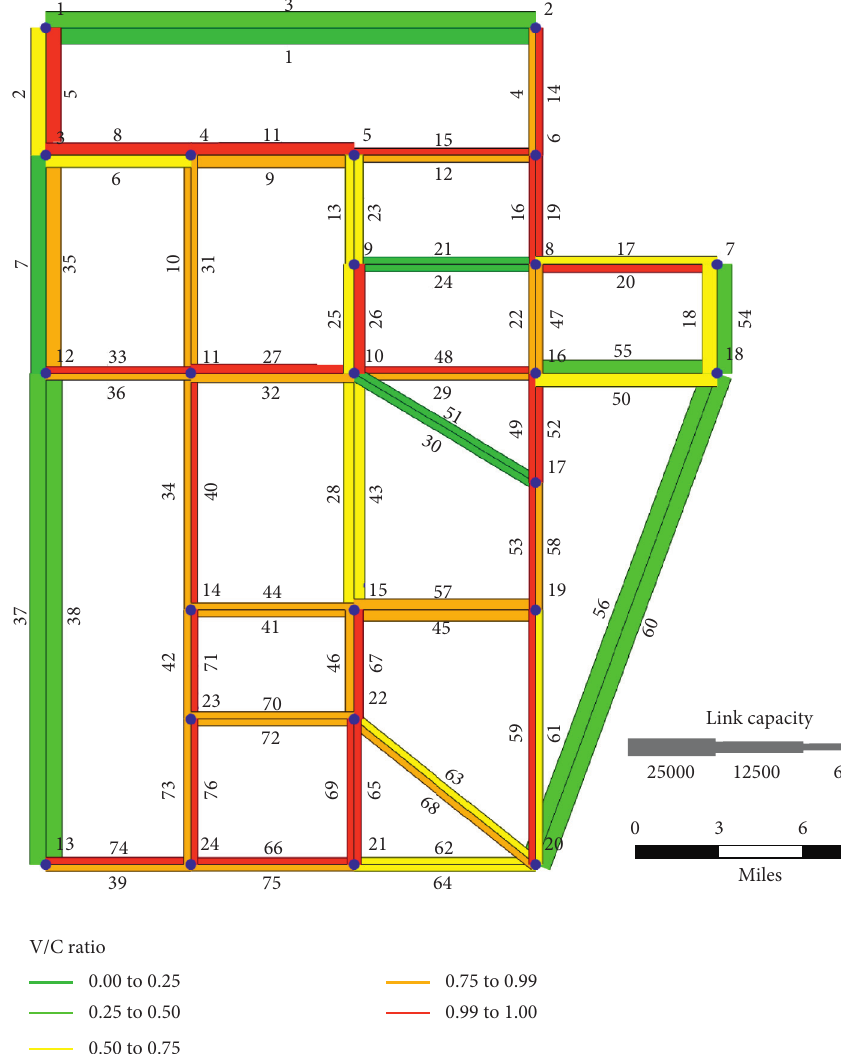
Figure 4: Link utilization pattern of maximum flow with an unlimited parking